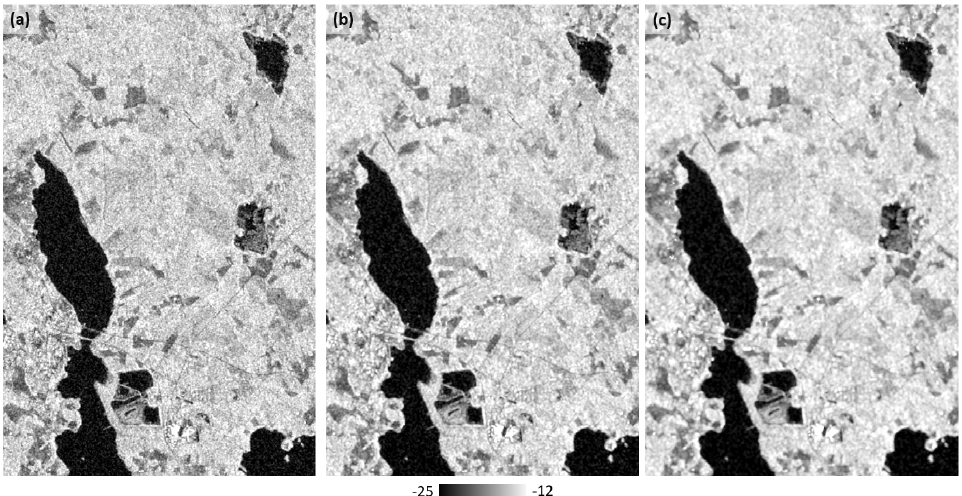
Figure 5. Sentinel-1 backscattering coefficients of study area after Lee speckle filtering with kernel sizes: ( a ) 3 × 3; ( b ) 5 × 5; and ( c ) 7 × 7; 12 May 2021, path